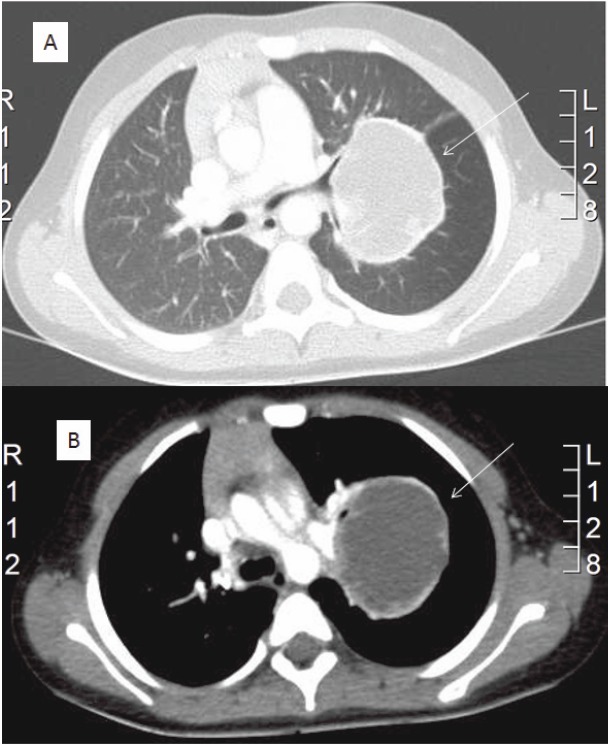
CT scan: (A) cystic tumour in the middle of left lung between the superior and the lower bronchus with maximum diameter of 10/8 cm (arrow); (B) close contact of the tumour (arrow) with the left pulmonary artery